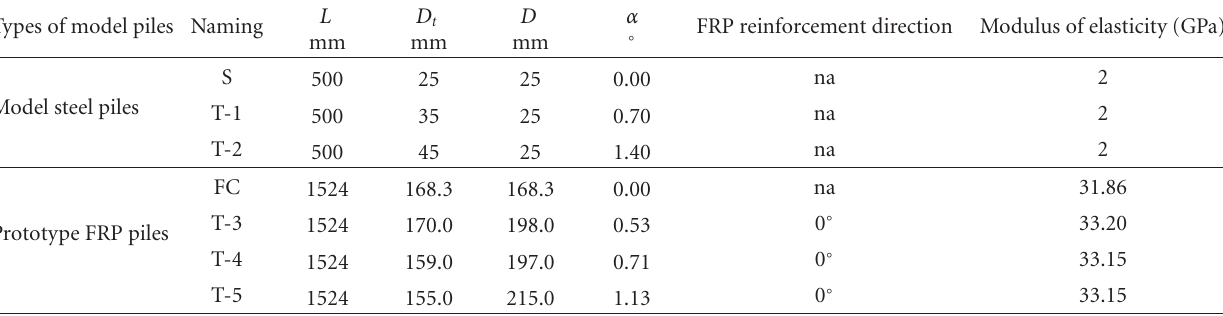
Table 1: Geometrical configuration of di ff erent types of piles.